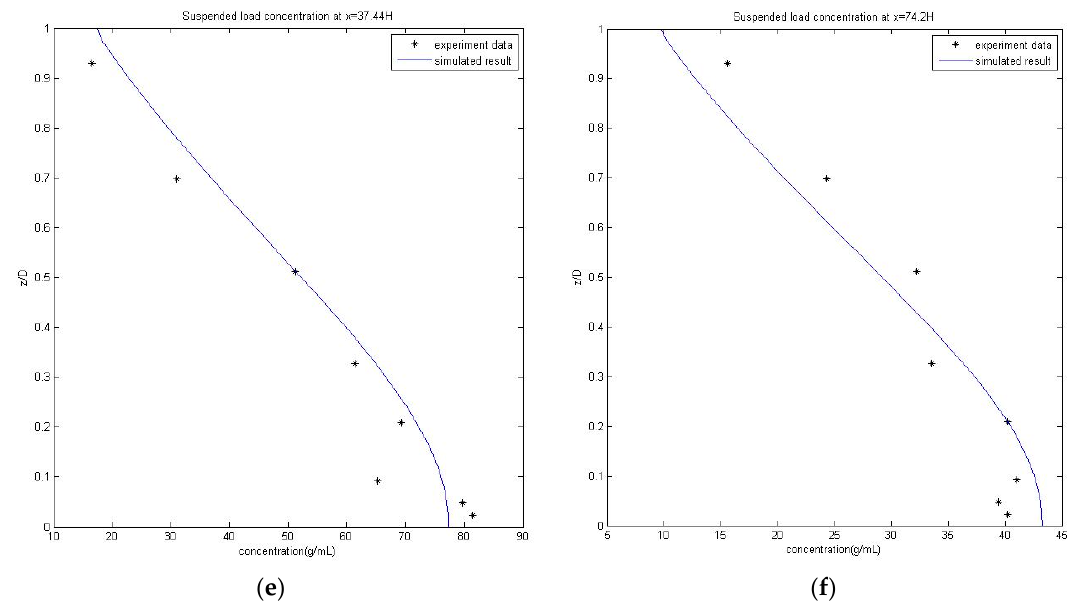
Figure 5. The model result of the zero erosion experiment ( a ) x = 0 H ; ( b ) x = 4.65 H ; ( c ) x = 9.3 H ; ( d ) x = 20.9 H ; ( e ) x = 37.44 H ; ( f ) x = 74.2 H .